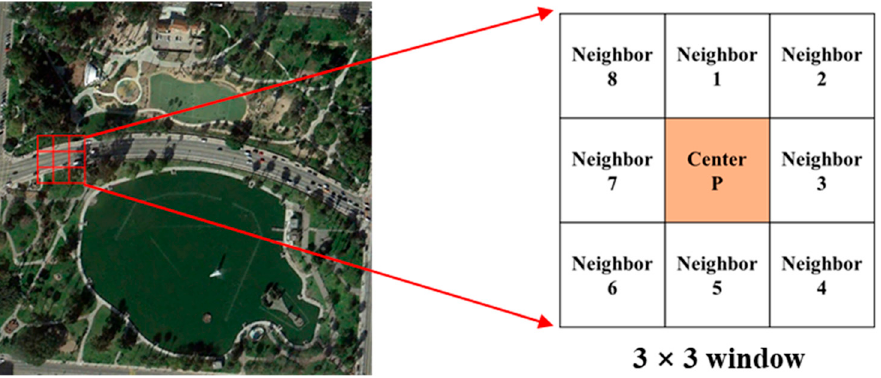
Figure 4. 3 × 3 windows for the neighborhood topology information content calculation. The num- ber in each window is the window’s